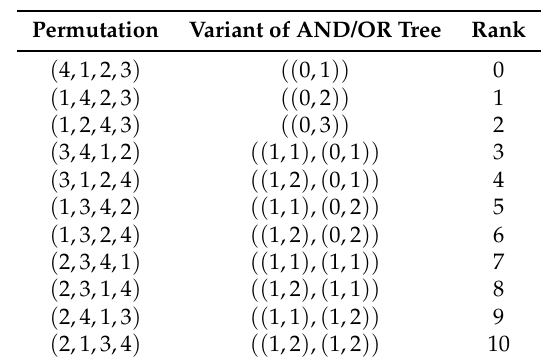
Table A3. Ranking the combinatorial set of permutations of n elements with m ascents for n = 4 and m = 2.